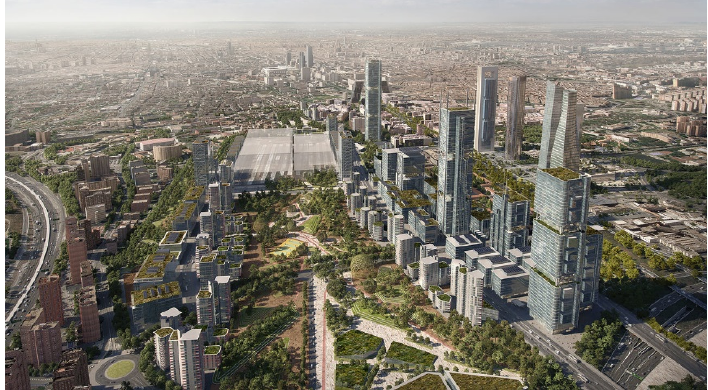
Figure 3. Recreation of the Madrid Nuevo Norte project (2020) [38]. Copyright 2020 DCN